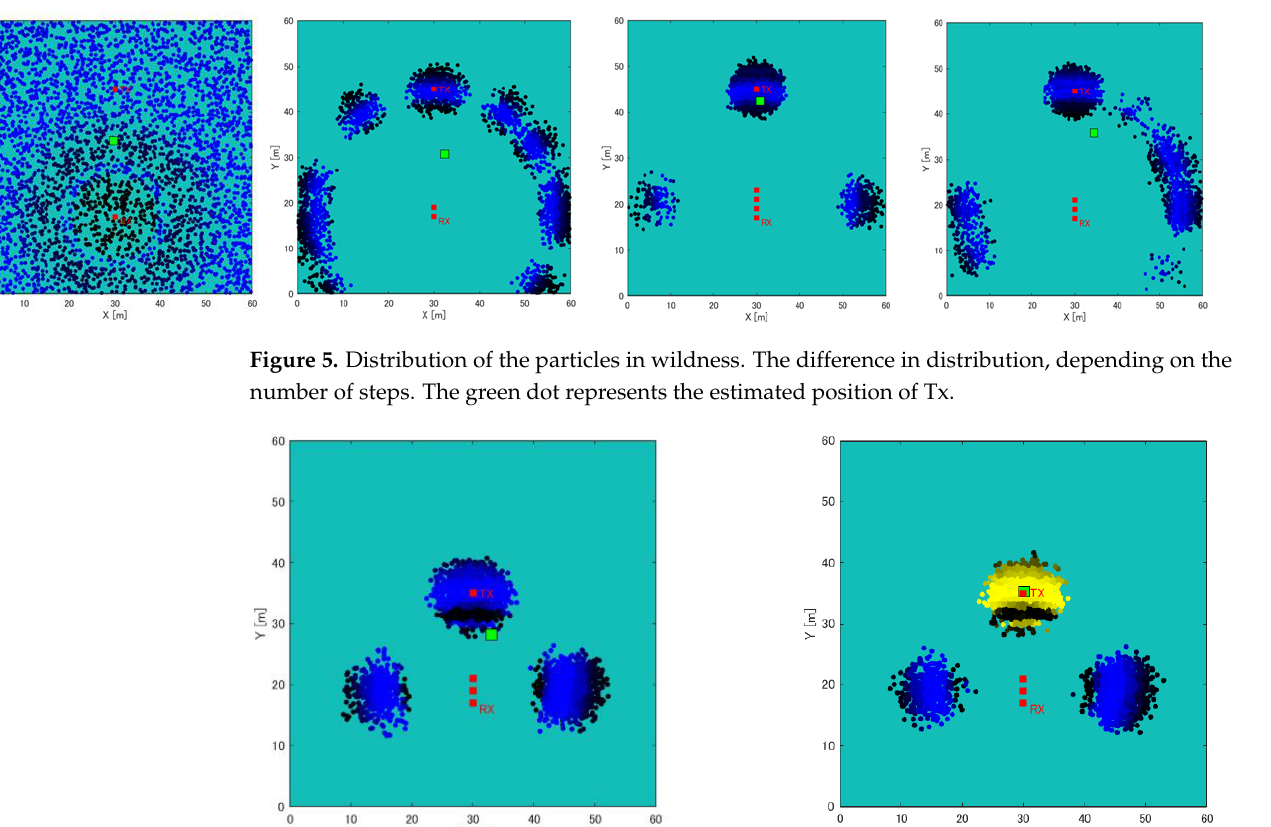
Figure 6. Position estimation results of measurement simulation using a particle filter. Left: weighted average; right: label method. The green dot represents the estimated position of Tx.